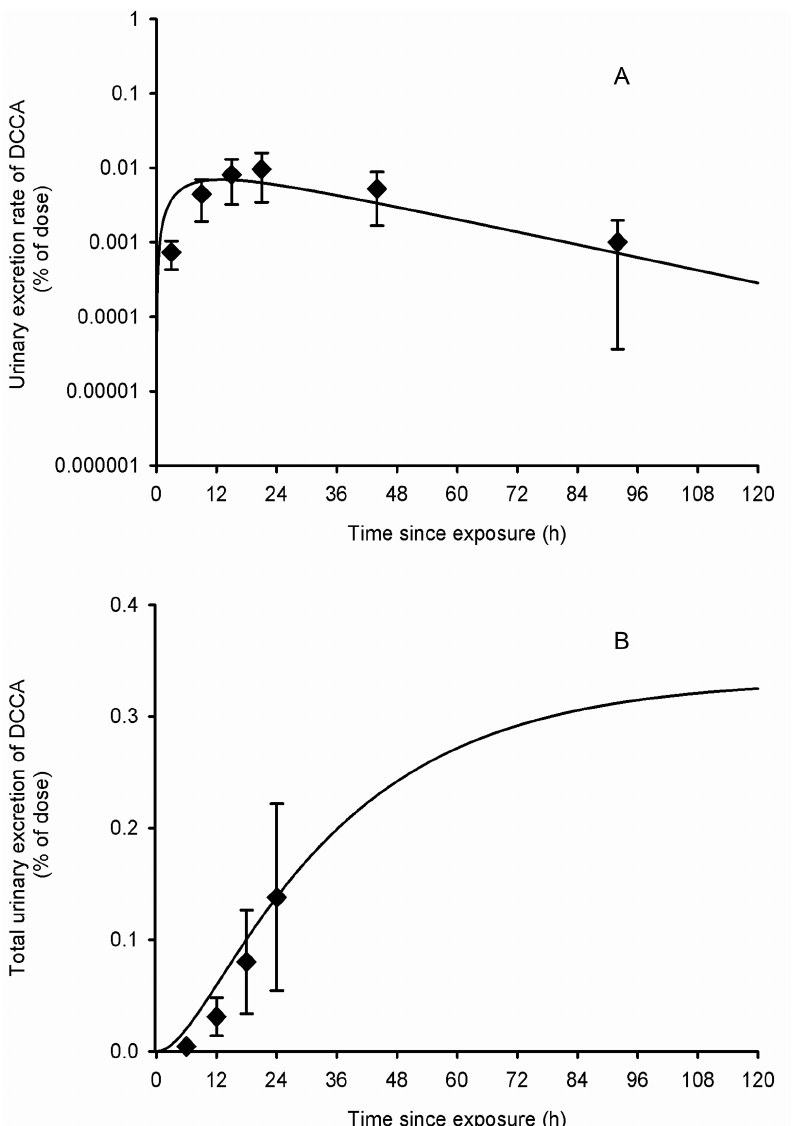
Figure 7. Comparison of model simulations with experimental data for DCCA (volunteers dermally exposed). Comparison of model simulations (lines) with experimental data of Tomalik-Scharte et al. (2005) (symbols) on the average time courses of DCCA excretion rate (A) and cumulative excretion (B) (% of applied dose) in healthy volunteers following a whole-body dermal application of a cream containing 3 g of permethrin. Diamond symbols represent average experimental values and vertical bars the experimental standard deviation